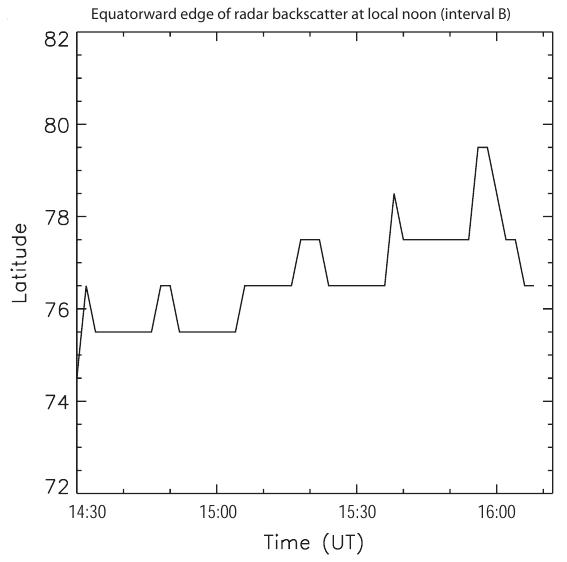
Fig. 17. The latitudinal position of the equatorward boundary of radar backscatter at local magnetic noon, observed between 14:30 and 16:10 UT during interval